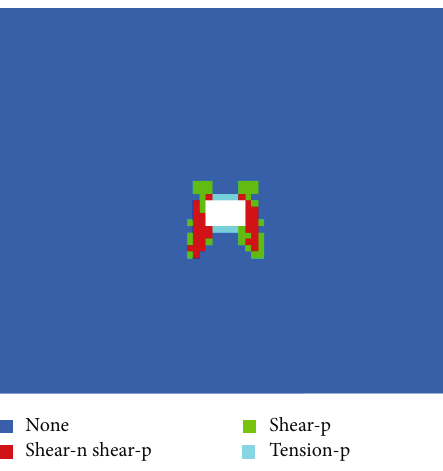
Figure 9: Plastic distribution nephogram of surrounding